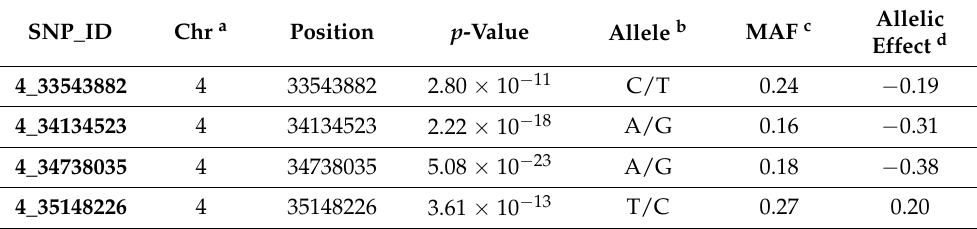
Figure 4. Manhattan plots of − Log 10 (P) vs. chromosomal position of significant SNP associations and respective quantile–quantile (Q–Q) plots on prickle data using FarmCPU model. Each chromosome is colored differently. The red dotted line in the Manhattan plot represents the association threshold ( − Log 10 p ≥ 5.98). SNPs reaching the genome-wide significance threshold are represented by red dots. A total of four significant SNPs were identified on the distal portion of chromosome 4 that were associated with prickle phenotype in the association analysis. The Q–Q plot of the FarmCPU model using prickle data indicated adequate control of false positives and negatives. Table 1. List of significant SNPs associated with the prickle phenotype using the FarmCPU model with a threshold of − Log 10 p ≥ 5.98.